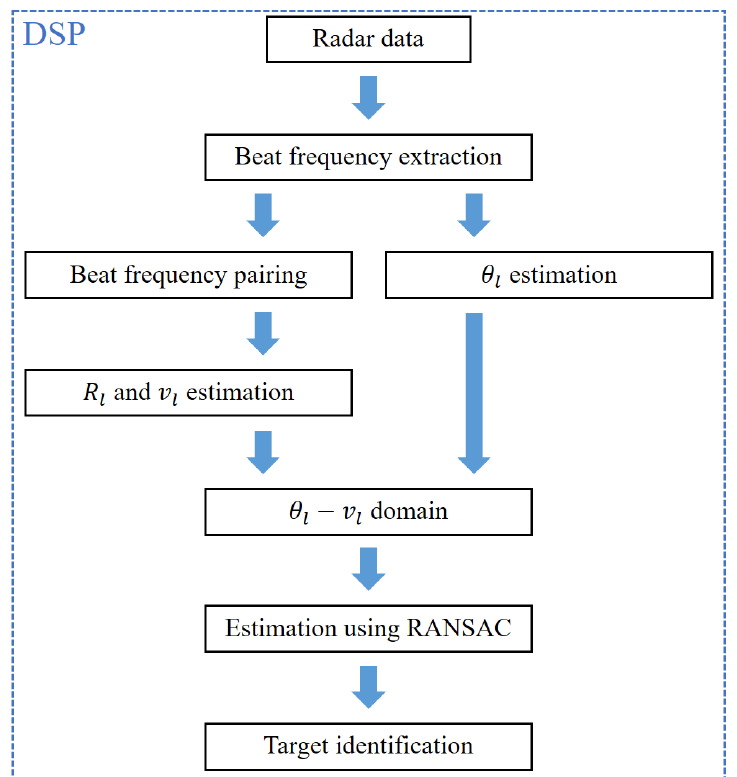
Figure 12. Flowchart of the proposed method (inside the